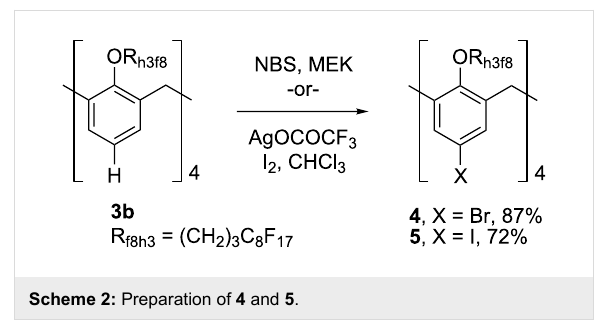
Scheme 2: Preparation of 4 and 5 .